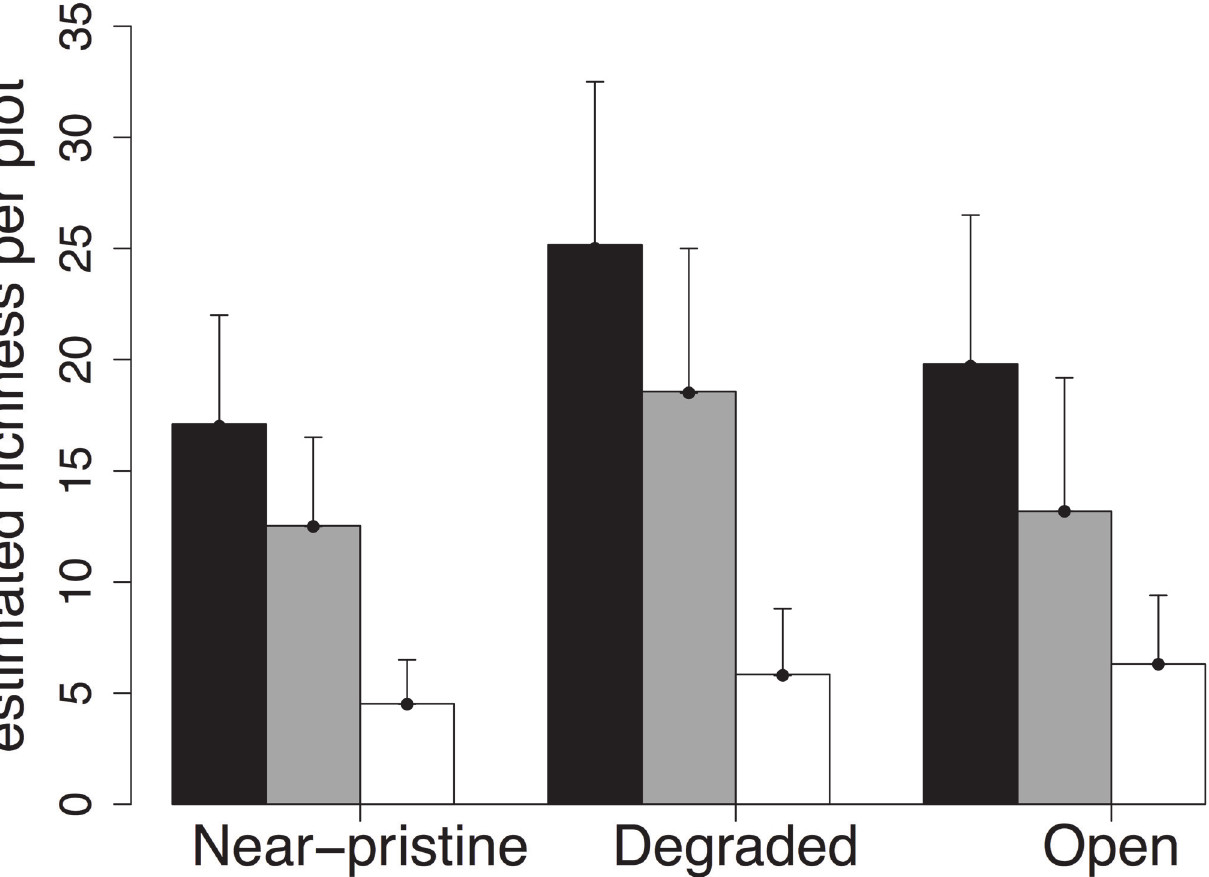
Fig 2. Estimated (Chao) bird species richness per plot by habitat type. Bar heights show mean estimated richness per plot and error bars represent standard deviation. Black bars represent all species, grey bars represent species with wide distributions (WD), and white bars represent species with medium and restricted distributions (MD and